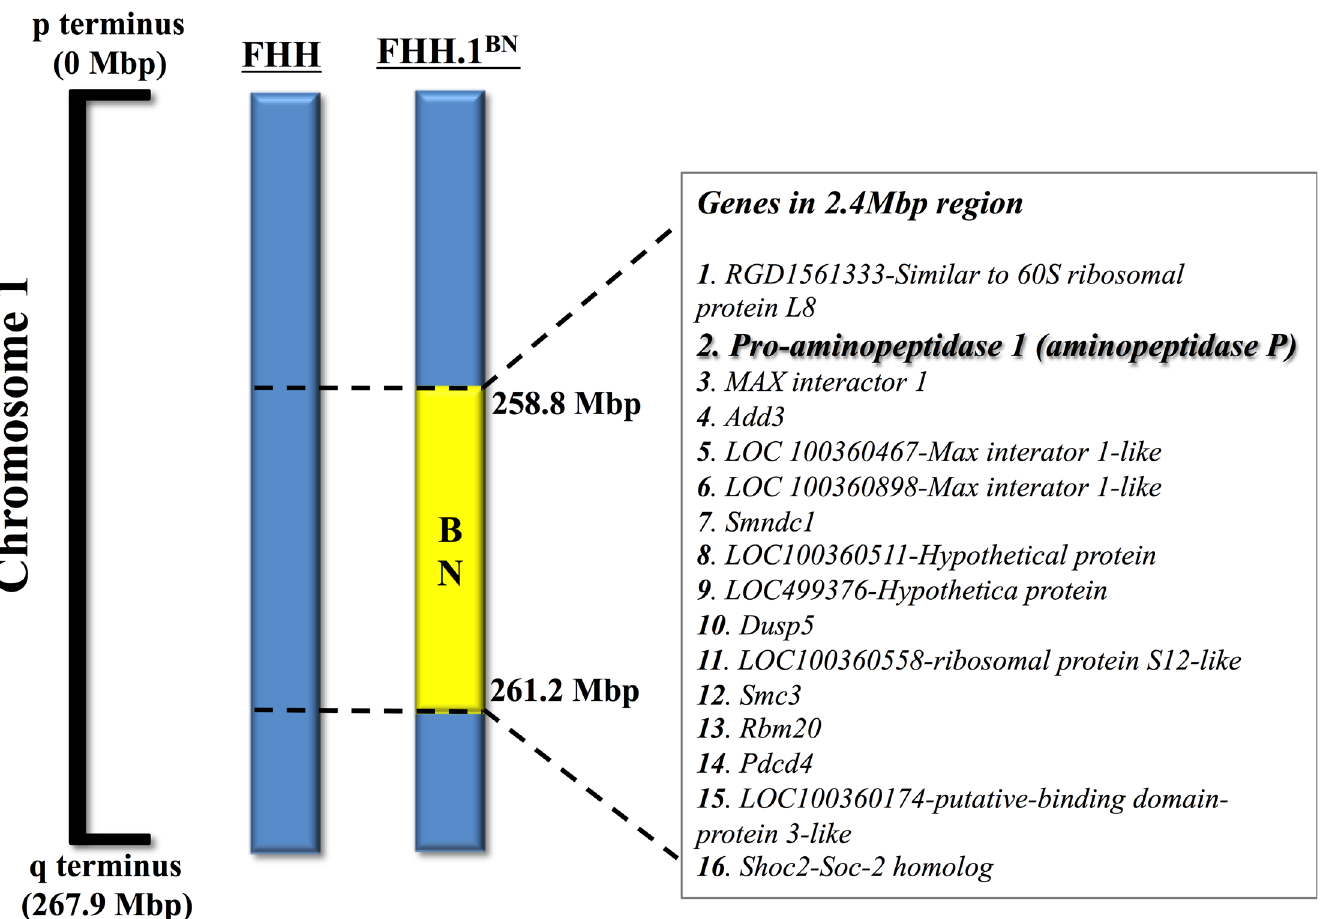
Fig 1. Illustrative depiction of the genetic map of introgressed region in FHH.1BN congenic rats. Genomic segments from the fawn-hooded hypertensive (FHH) and Brown Norway (BN) rat are presented as blue and yellow bars, respectively. Aminopeptidase P and 15 other genes harbored in the 2.4 Mbp region of interest on rat chromosome 1 are shown. The concept of this figure is adapted from earlier studies